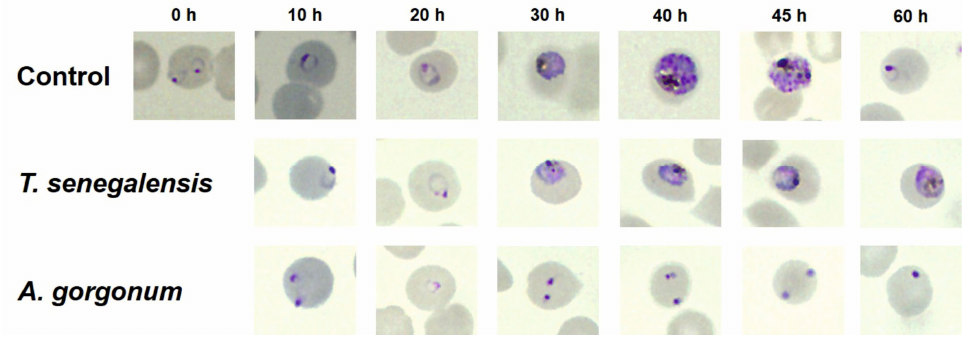
Table 2. EC 50 values of studied plant extracts against P. falciparum .